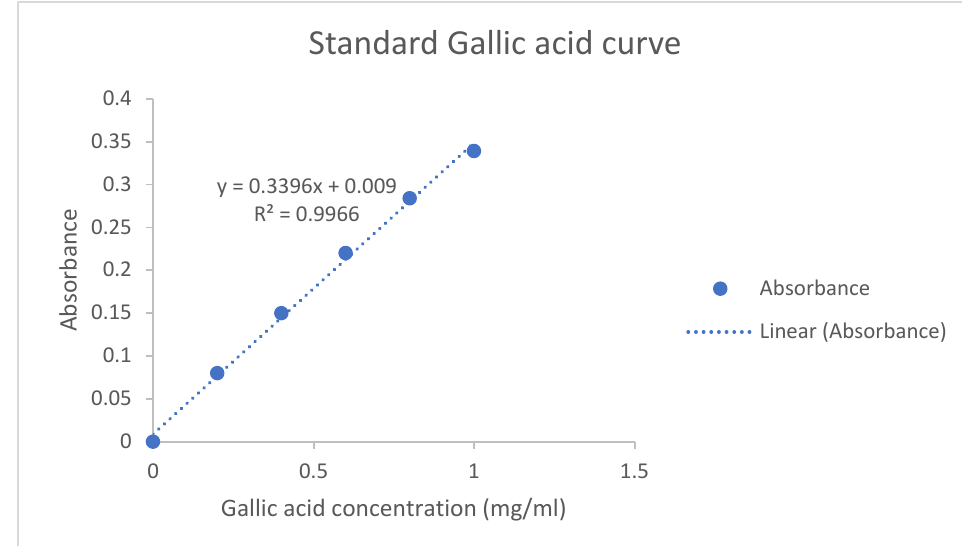
Figure 1. Standard gallic acid curve for total phenolic content. Similarly, the total flavonoid content was determined using a quercetin standard curve at 510 nm, where the equation obtained was y = 0.4879 × + 0.0002 with a regression coefficient (R 2 ) = 0.9996. The plot has a slope (m) = 0.4879 and intercepts = 0.0002 (Figure 2). Total phenolic content (TPC) showed a significant ( p < 0.05) decrease with increasing the time of drying. The range varies from 3.5 to 2.9 mg GAE/g. The value of phenolic content was compared with similar findings reported by Compaore et al. [35]. In addition, the total flavonoid content (TFC) (23.6 to 12.3 mg QE/g) was significantly ( p < 0.05) higher observed during drying at different temperatures. The final value of flavonoid content